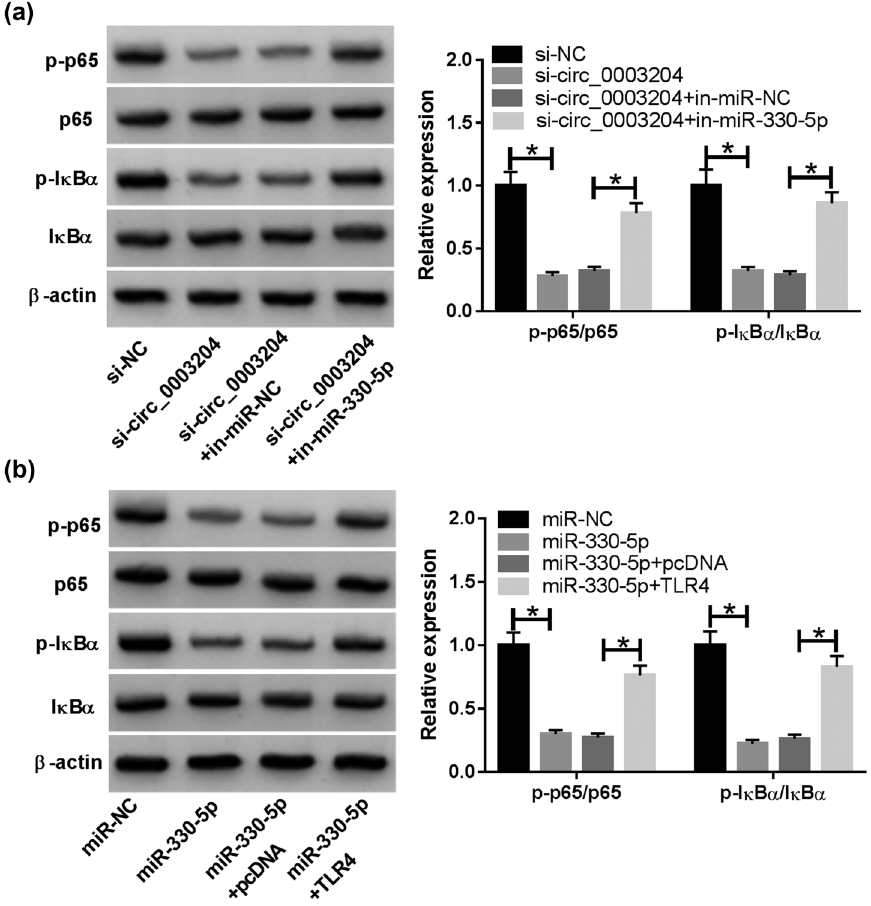
Figure 7: The circ_0003204/miR - 330 - 5p/TLR4 axis regulated the activity of the NF - κ B signaling pathway. ( a ) HUVECs were transfected with si - NC, si - circ_0003204, si - circ_0003204 + in - miR - NC, or si - circ_0003204 + in - miR - 330 - 5p, followed by treatment with ox - LDL. The